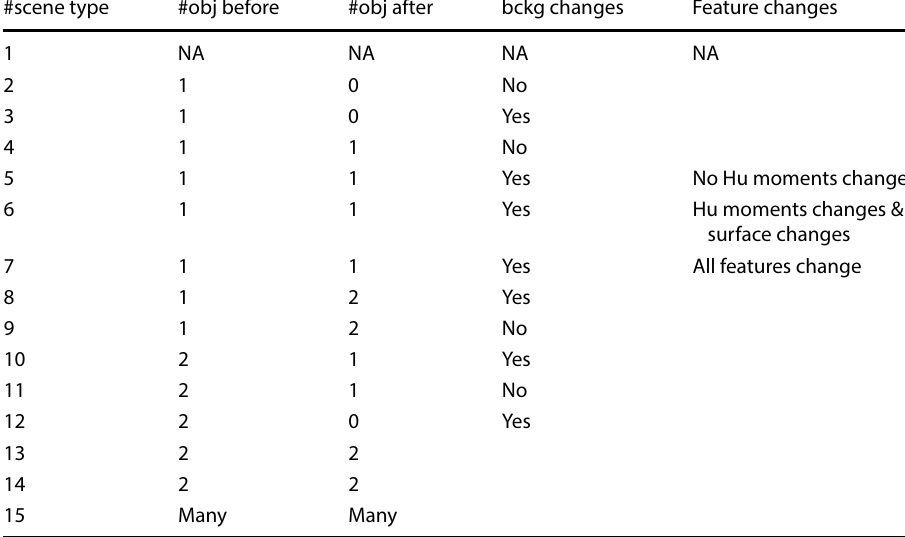
#scene type #obj before #obj after bckg changes